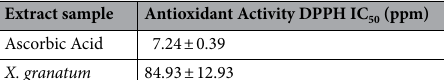
Table 3. Antioxidant IC 50 for extract and ascorbic